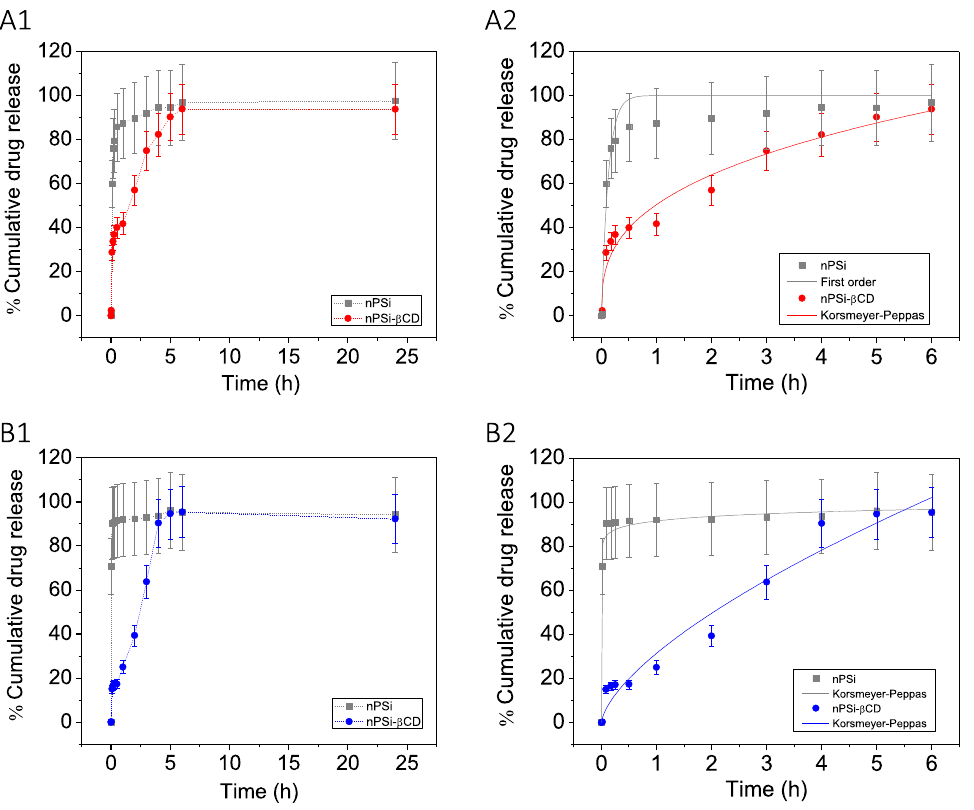
Figure 7. Polyphenols release profiles in phosphate-bu ff ered saline (PBS) at 37 ◦ C: ( A1 , A2 ) CA and ( B1 , B2 ) Pin. Table 1. In vitro release kinetics of ca ff eic acid and pinocembrin in PBS at 37 ◦